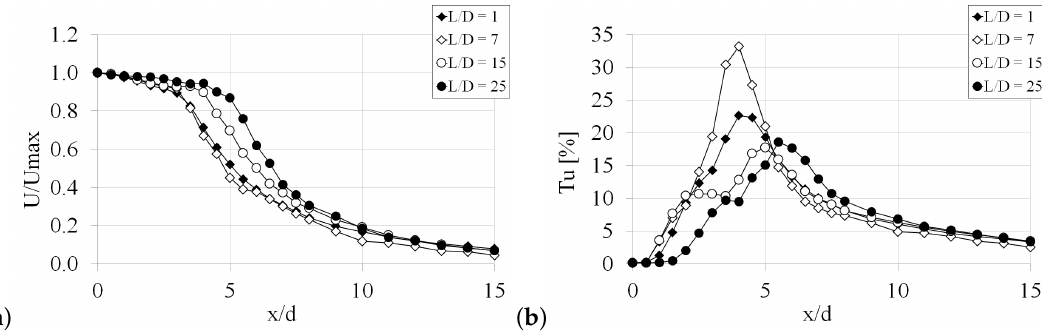
Figure 12. ( a ) Mean and ( b ) fluctuating velocity profiles along the jet axis, S = 0.5, Re = 10,000.